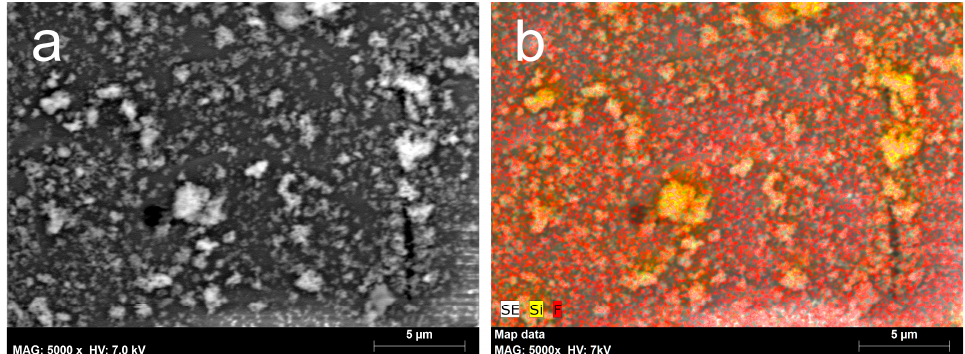
Figure 1. SEM images of the FSNP1.0-modified Scots pine wood in tangential section. ( a , b , d ): FSNPs